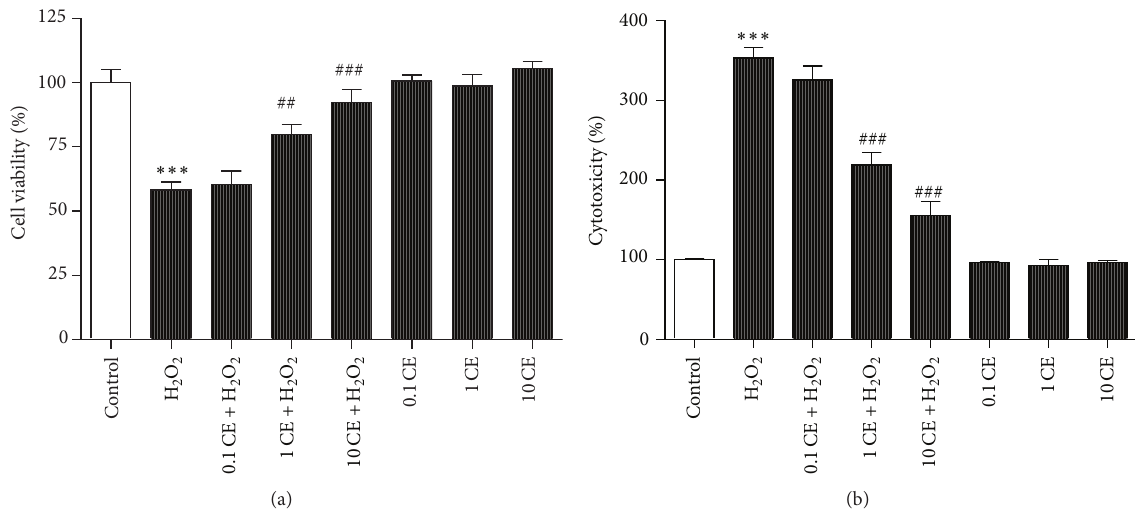
Figure 1: Protective effects of CE against oxidative stress in primary cultured cortical neurons. (a) Bar graphs showing the reduced cell viability after H 2 O 2 treatment that was significantly attenuated by the treatment of the neurons with 1mg/mL and 10mg/mL CE as tested by MTT assay. (b) Bar graphs showing the H 2 O 2 induced cytotoxicity that was significantly reduced by the treatment of the neurons with 1mg/mL and 10mg/mL CE as tested by LDH release assay. ∗ refers to a comparison of the control group and # refers to a comparison of the H 2 O 2